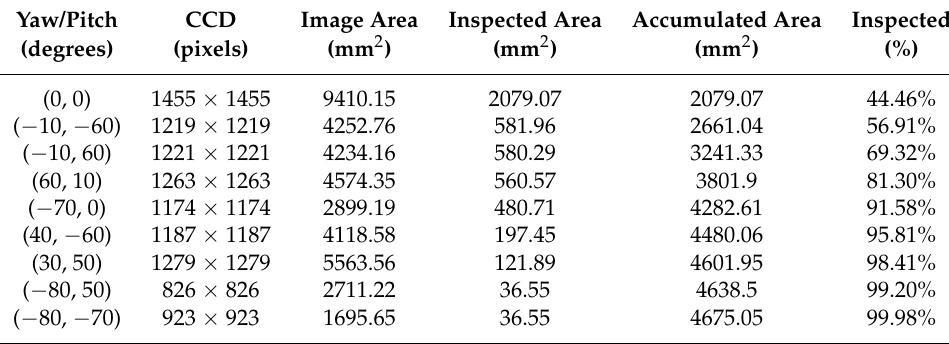
Table 5. Environment and camera characteristics to acquire nine images needed to inspect the metallic logo using ‘ Interlaced XY ’